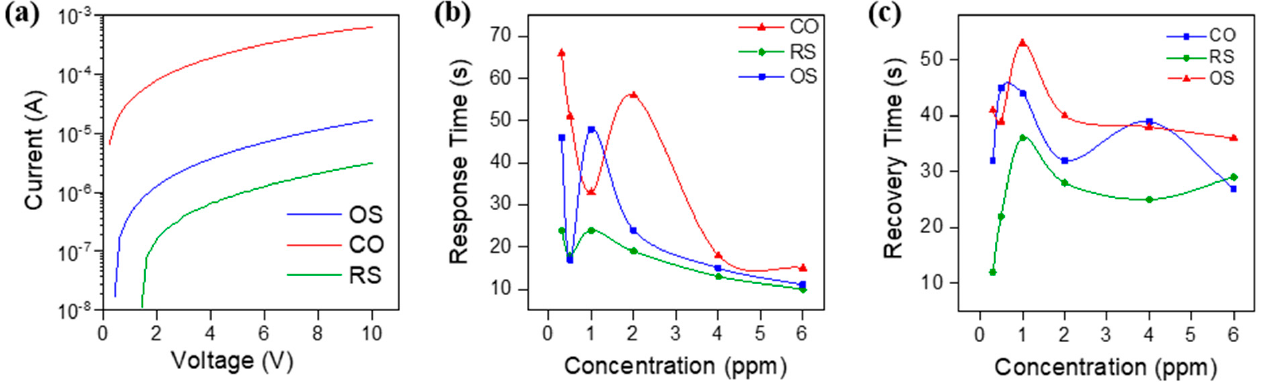
Figure 7. ( a ) I–V characteristic curve, ( b , c ) the response and recovery time of the Sn 3 O 4 -RGO-based sensor to various concentrations CH 3 COOH at room